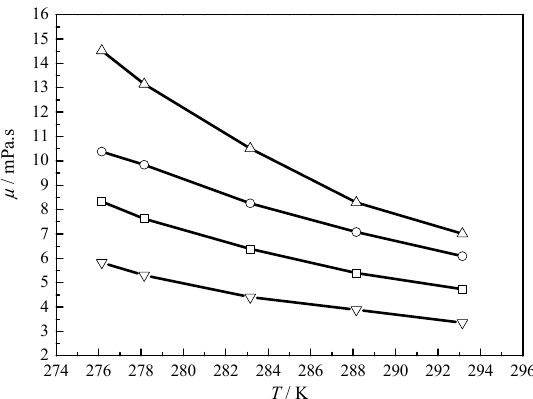
Figure 5. Viscosity of ( ▽ ) diesel oil and water-in-oil emulsion with AA-5 for water cut of ( □ ) 10 vol %; ( ○ ) 20 vol %; ( △ ) 30 vol %. Lines are provided to guide the eye.